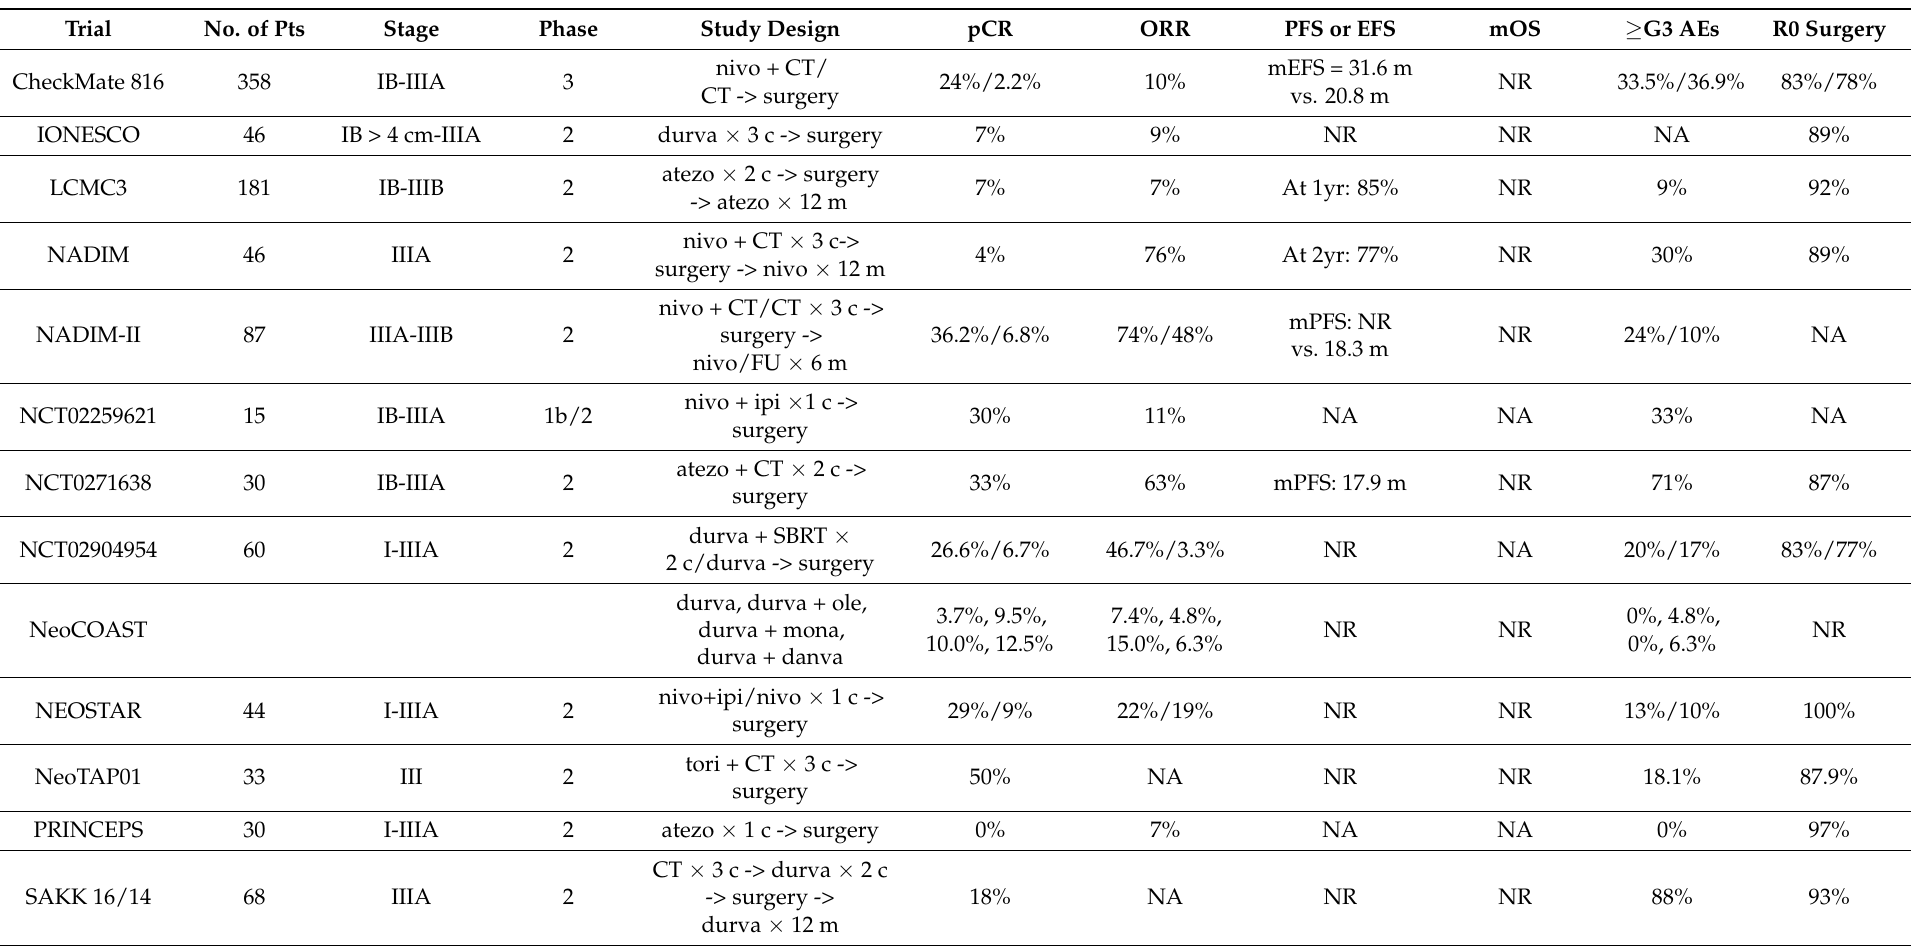
Table 1. Trials of neoadjuvant immunotherapy in resectable early NSCLC (results